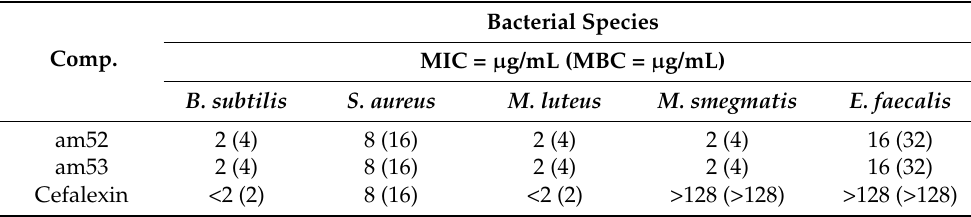
Table 24. Results of antimicrobial screening of the synthesized compounds (am52 – am53 ).